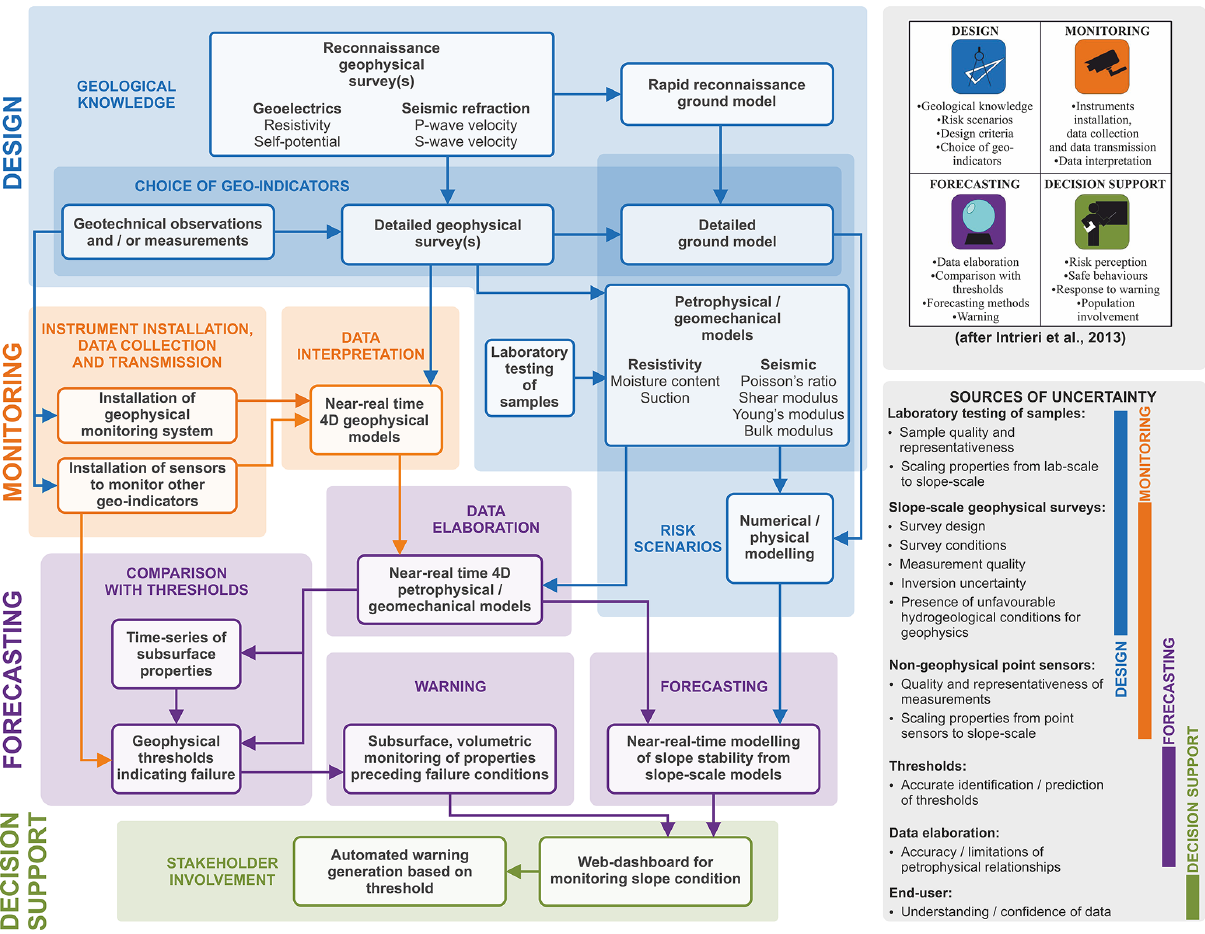
Figure 1. A conceptual workflow illustrating the role of geophysics, supported by geotechnical observations and laboratory measurements, in establishing LoLEWS for landslides triggered by increases in ground moisture conditions. The uncertainties associated with different activities are also identified. Inset shows a modified version of the framework proposed by Intrieri et al. (2013), where we use the term “decision support” instead of “education” and “stakeholder involvement” instead of “population involvement”. “Instrument installation”, “data collection” and “data transmission” are considered to be a single monitoring sub-component. The processing and interpretation (i.e. “data interpretation”) of geophysical data are considered a monitoring activity, and the integration and translation of geophysical data (i.e. “data elaboration”) are considered a forecasting